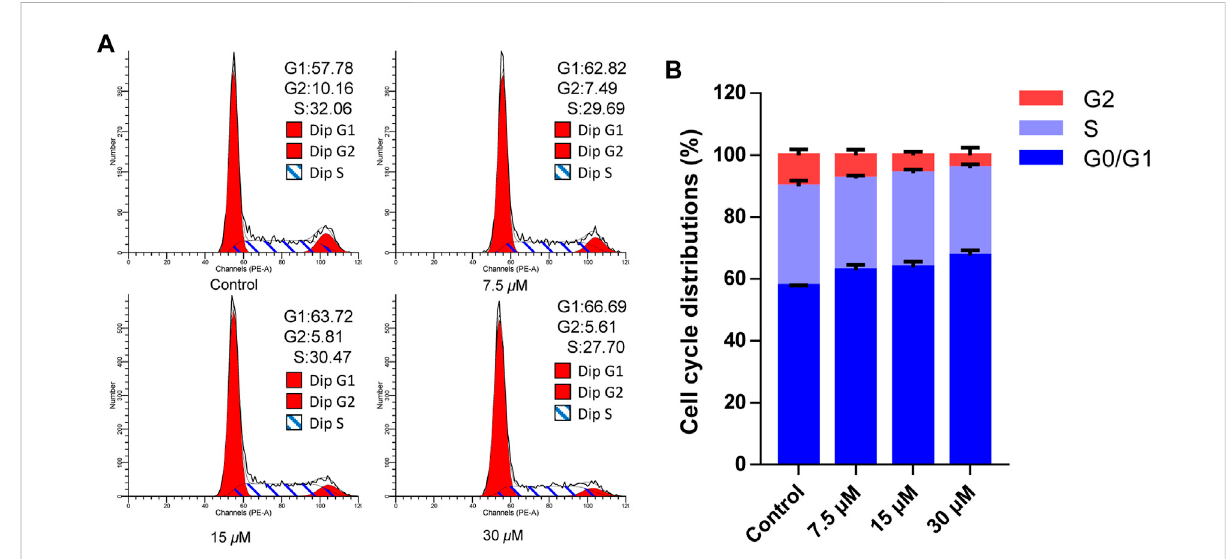
FIGURE 5 Cratoxylumxanthone C arrested G0/G1 phase in A549 cells. A549 cells were treated with different concentrations (7.5, 15, and 30 μ M) of cratoxylumxanthone C for 48 h. Then the cells were stained with propidium iodide (PI), and the cell cycle distribution was analyzed using fl ow cytometry. (A) FlowcytometricanalysisofA549cellsaftertreatedwithdifferentconcentrationsofcratoxylumxanthoneC. (B) Histogramofcellcycle phases